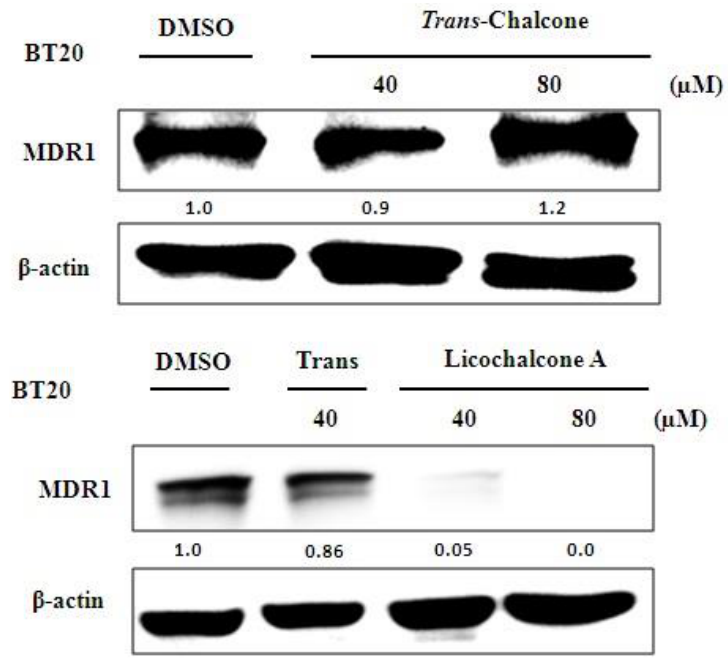
Figure 6. Western blot assays for expression of the proteins MDR-1 on BT-20 breast cancer cell line through the treatments of the different concentrations of trans -chalcone and licochalcone A for 24 h.